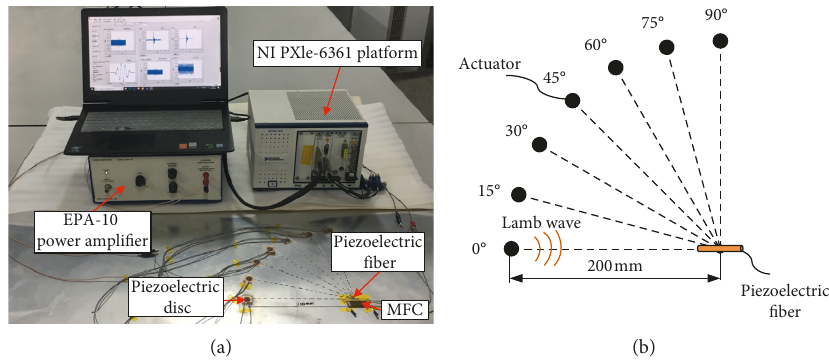
Figure 6: (a) Experimental test setup; (b) configuration of